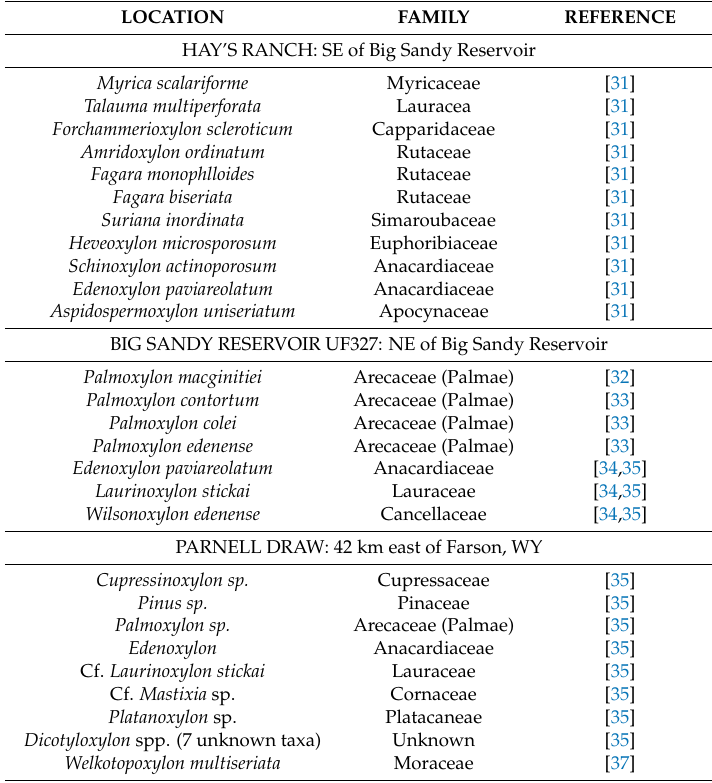
Table 1. Known plant taxa from southwestern Wyoming